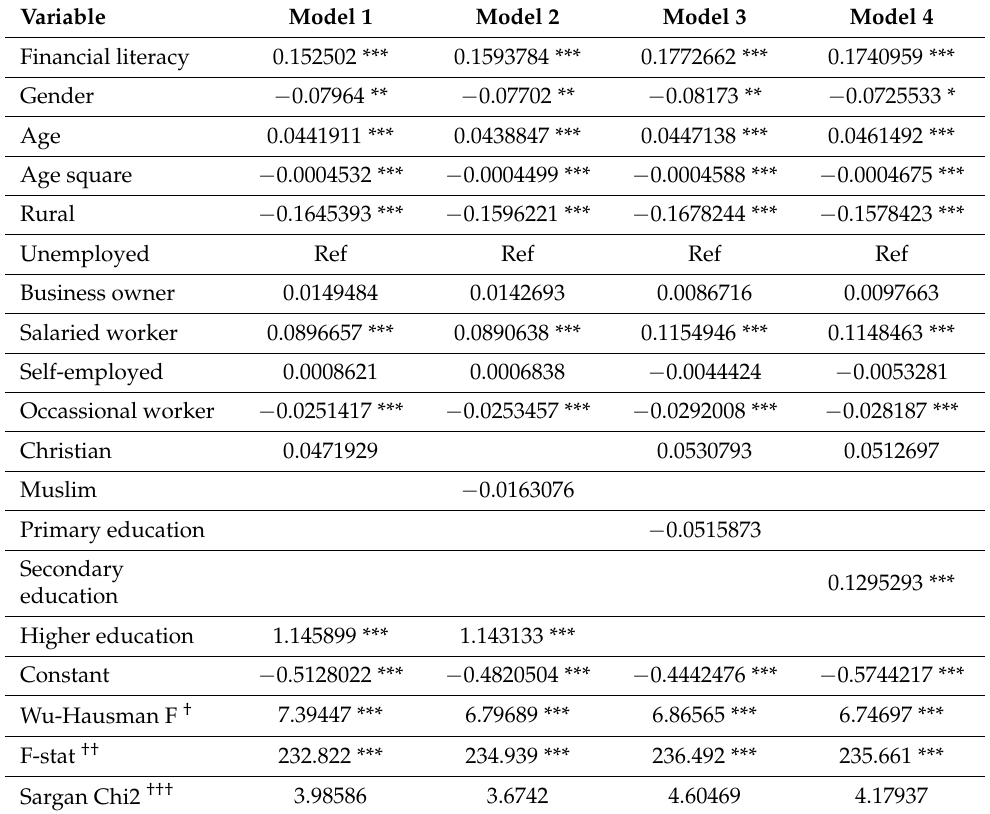
Table 5. Financial literacy and financial inclusion in Tanzania: IV regression